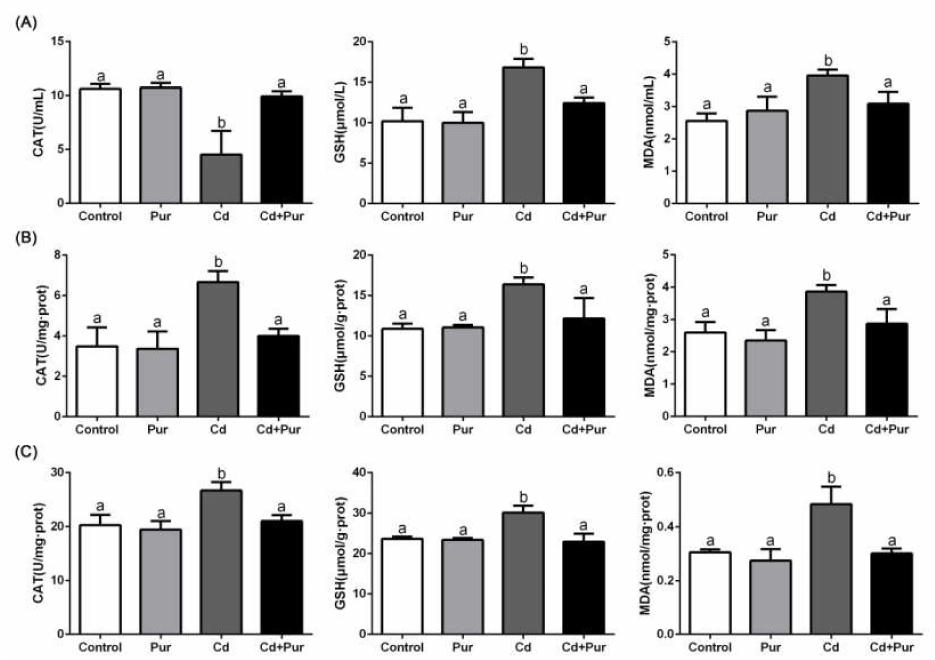
Figure 2. Pur alleviates Cd-induced oxidative stress in the rat serum and cerebral cortical neurons. The rats were treated with Cd (50 mg/L) and/or Pur (200 mg/kg) for 90 days. Primary cortical neurons were pretreated with 100 µ M Pur for 1 h, followed by exposure to 10 µ M Cd for 12 h. The levels of CAT activity, GSH, and MDA were evaluated in the rat serum ( A ), cerebral cortex ( B ), and primary cortical neurons ( C ). Data are expressed as the mean ± SD ( n = 3). The means labeled without a common letter (a, b) are significantly different, p <